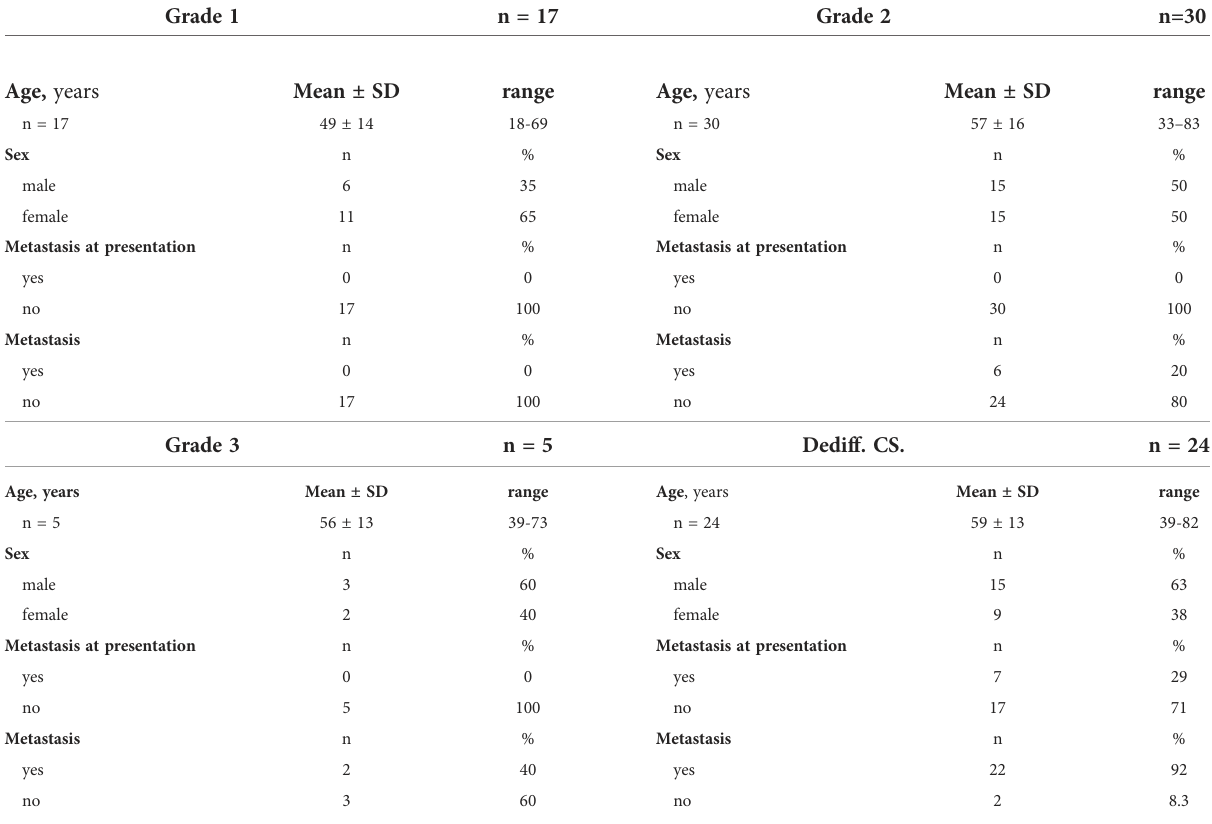
TABLE 1 Chondrosarcoma-clinical and pathological characteristics, n =